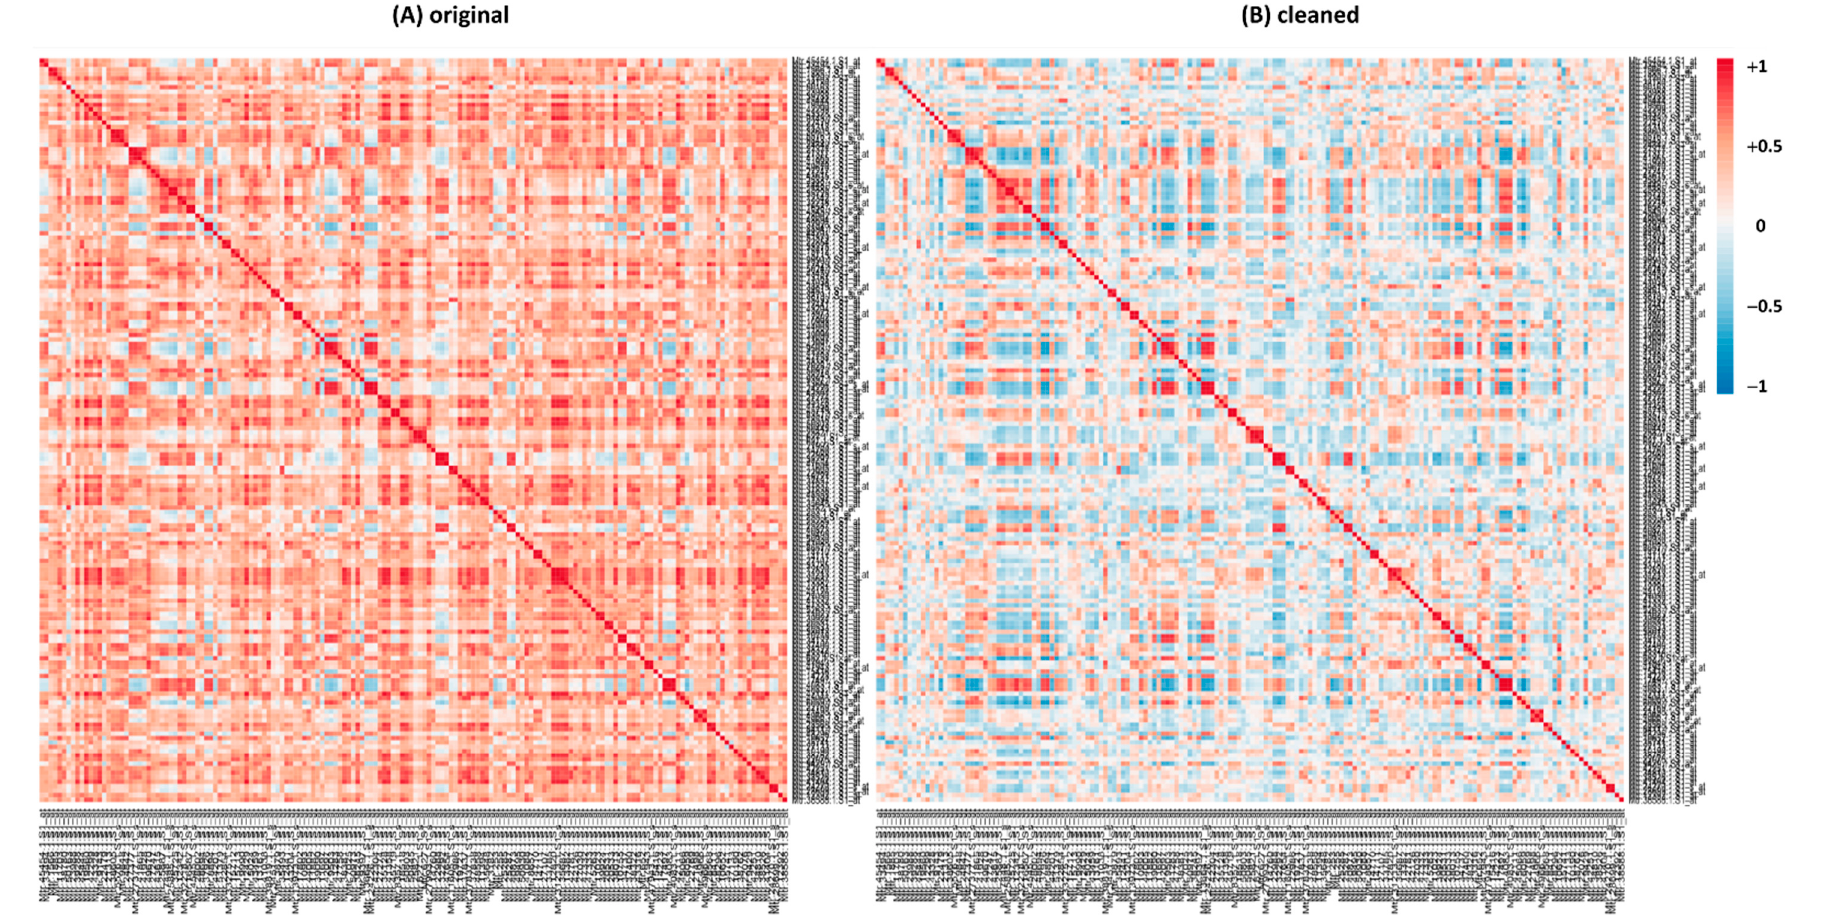
Figure 4. Heatmaps generated for Pearson correlation coefficients in the logarithmic version for the TFs family bHLH, with expression values from original ( A ) and cleaned ( B ) Log datasets (Table S15A,B).